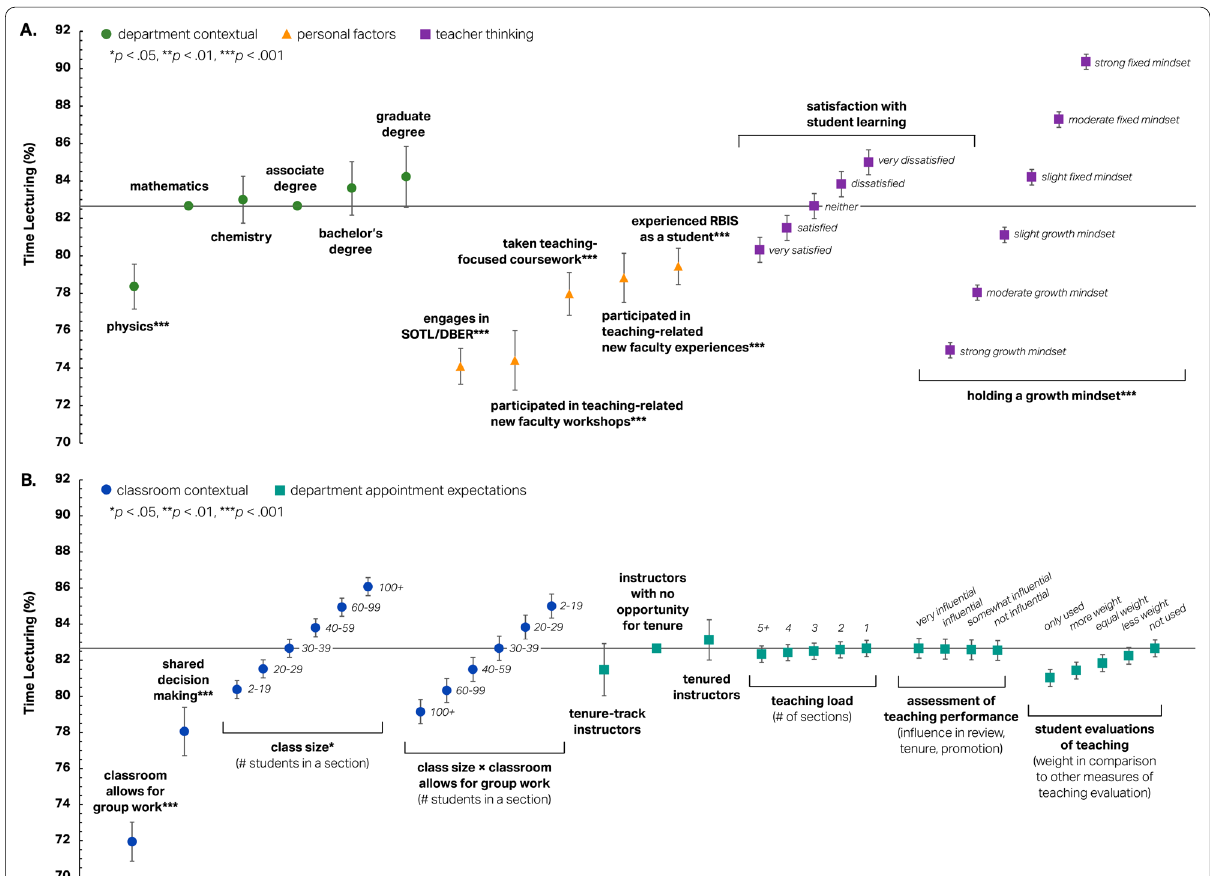
Fig. 2 Comparative association of variables with percent time lecturing: A Department characteristics, personal factors, and teacher thinking. B Classroom contextual factors and department appointment expectations. The line at 82.66 represents the intercept of the